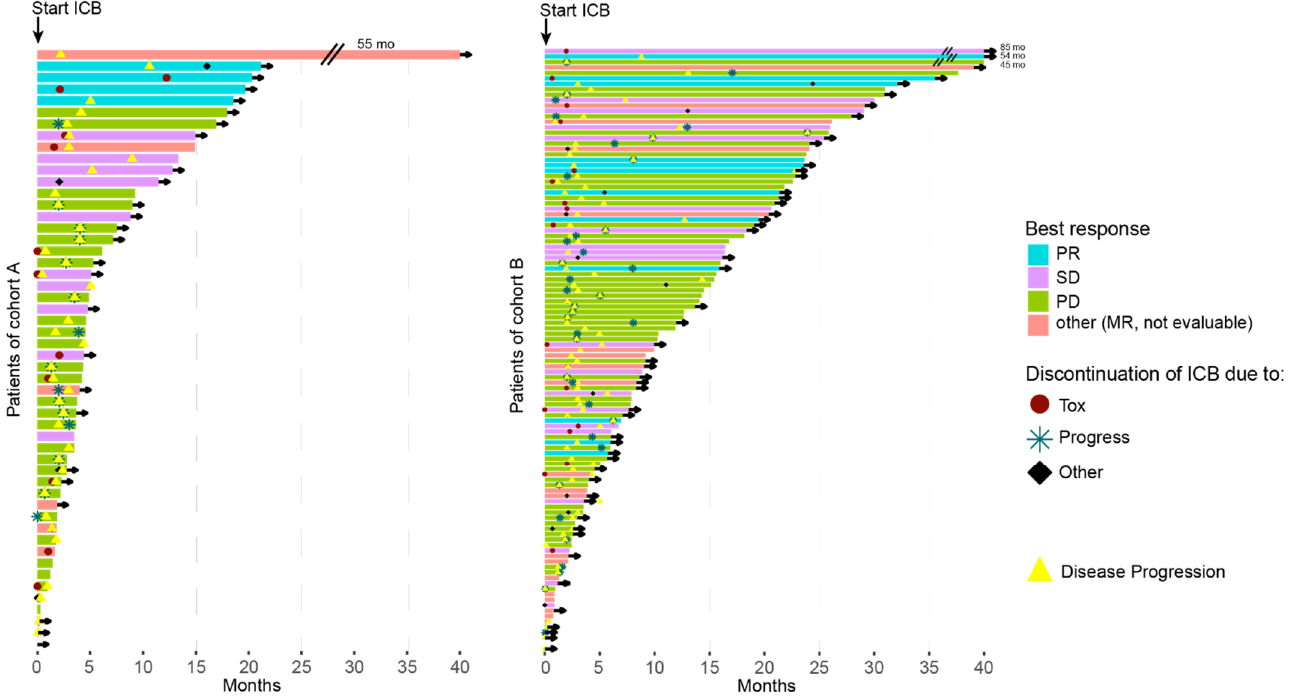
Figure 2. Swimmer plots for cohort A (left) and B (right) demonstrating the OS for each patient. The color shows the best response to ICB, the symbols depict the reason for treatment discontinuation and the yellow triangle shows the time of tumor progression. If a patient was censored, an arrow is drawn.